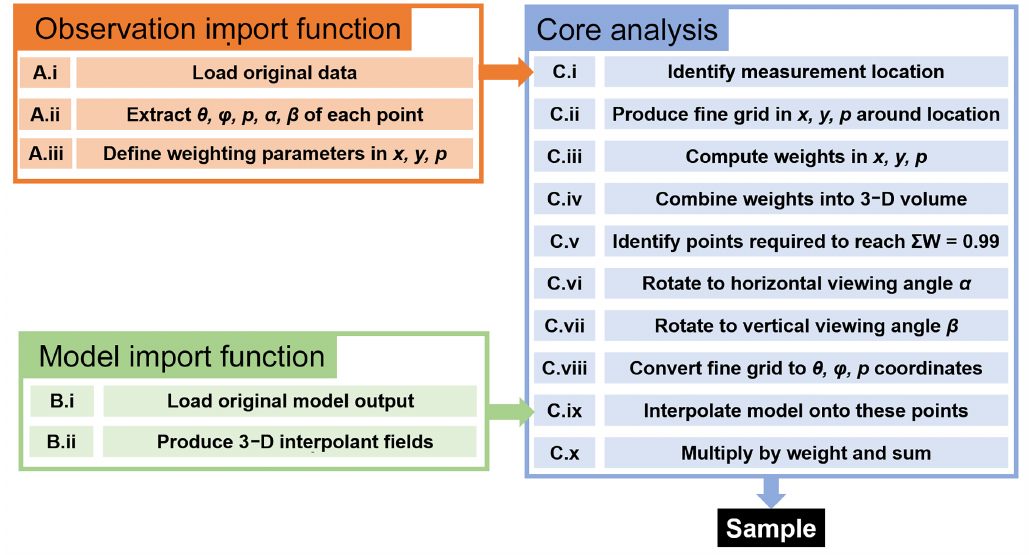
Figure A1. Schematic outline of the sampling process. See text for further details.